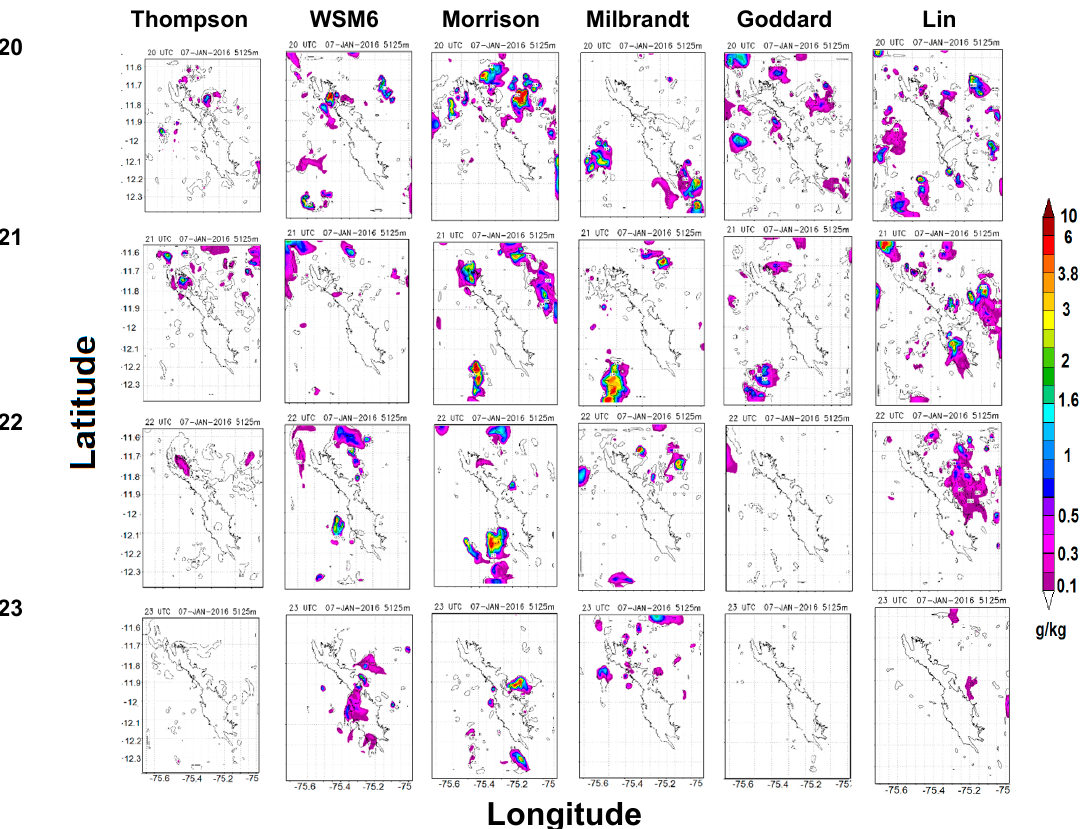
Figure 14. Evolution of the horizontal field of the rainwater + graupel mixing ratio (Q g+r ; g/kg) at the WRF output level of 5.1 km every 30 min. from 20:00 UTC to 23:00 UTC for CRE2. For CRE2, even if the wind field evolution in the early afternoon was similar for the two configurations, the onset of Q g+r near HYO initiating the development of the convective cloud system was different. The analysis of the model output of CRE2 showed that Lin produced significant Q g+r greater than the 0.1 g/kg threshold, implemented in the figure color bar since 19:40 UTC, conditioned by the convergent flow related with a convective system in the eastern slopes of the surrounding basin. This is consistent with the beginning of the CRE2 radar trace, but the simulated system did not match the whole duration of the radar record. The initiation time of Q g+r near HYO for Morrison was only half an hour before the radar record, but the simulated rainfall on the ground only matched the last part of the record. The situation is complicated by the existence of two simultaneous systems affecting the local wind field. Morrison simulated the intense convective system approaching the basin from the northeast, mainly from 20:00 to 22:30 UTC, and after its decline, began to reproduce the system in the center of the valley. In the case of Lin, it failed to reproduce the early system in the north, but in the 20:20 cross section, several isolated cells appeared between the northern border and the center of the valley, while a narrow band was formed in the eastern border, as a result of the convergent orographic flow, later developing the simulated system reaching HYO. After 21:30, it produced an extension of the convective zone, merging with a widespread convective system from the bordering mountains.